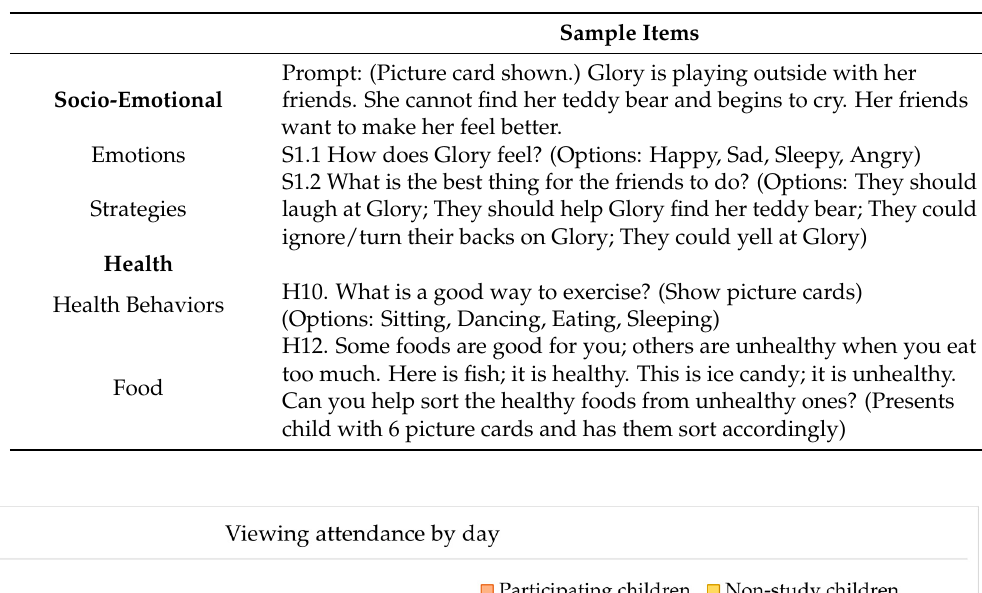
Table A1. Sample items from the questionnaire.